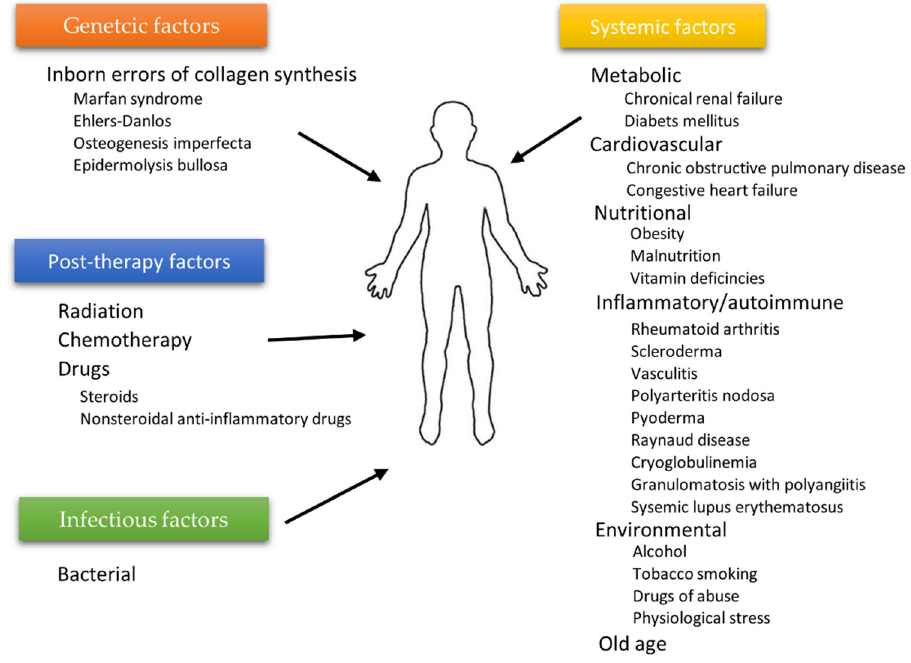
Figure 3. Factors affecting wound healing according to Beyene et al. [32].